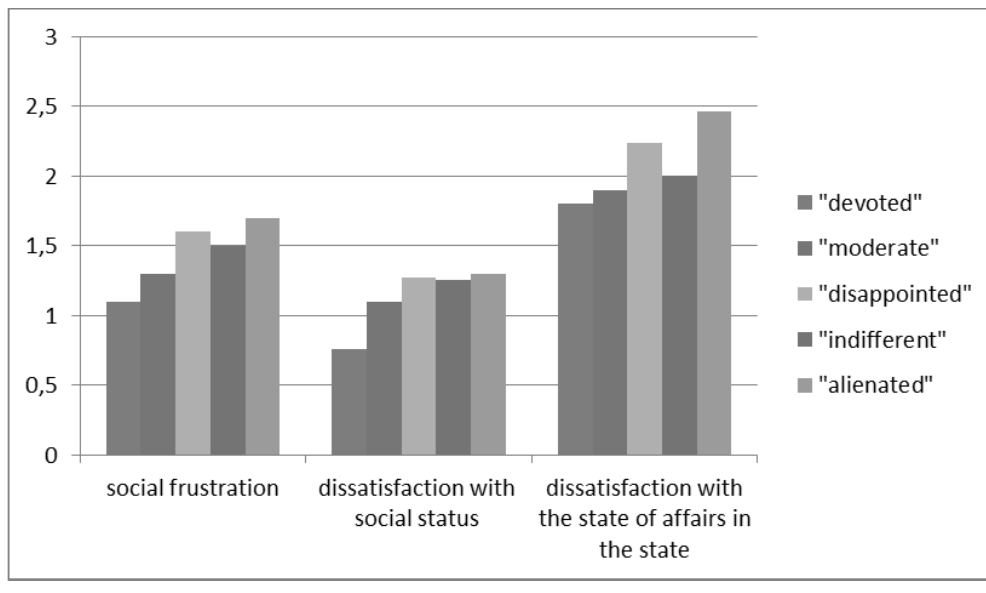
Indicators of social frustration of citizens with various types of civic identity Source: Own